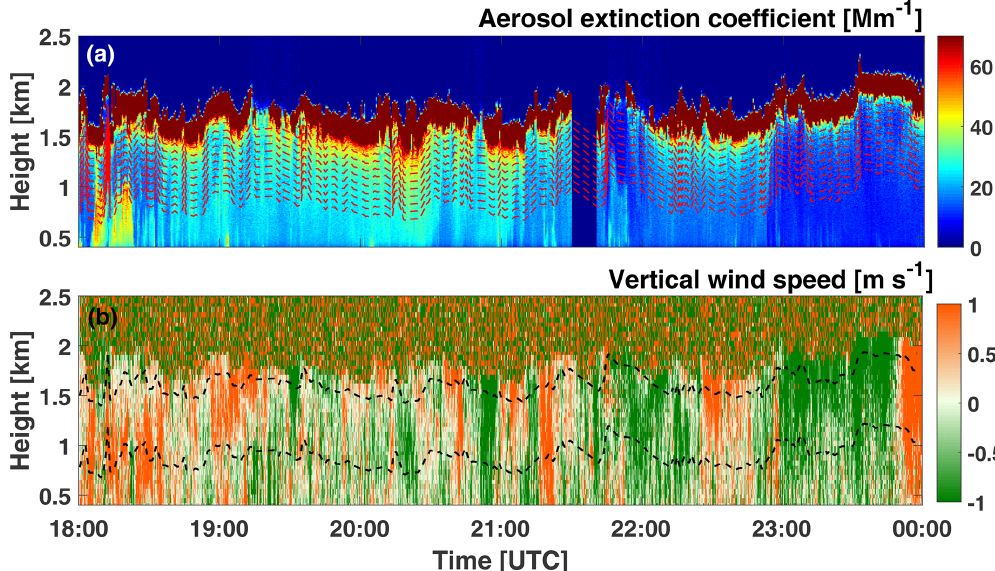
Figure 8. Lidar observation of the convective cloud-topped planetary boundary layer in the afternoon and evening of the summer day of 23 February 2019. (a) Aerosol extinction coefficient (blue to yellow colors) up to the base of the stratocumulus layer (dark red) at around 1500m height and (b) vertical wind component (orange: upward motion, green: downward motion) measured with the zenith-pointing Doppler lidar of the LACROS facility. The cloud base strongly varies with the permanently changing updraft and downdraft conditions. Dashed red curves in (a) show height levels of constant distance of 75 to 750m from the cloud base. The dashed black lines in (b) show the cloud base height z bot and the height level 750m below the cloud base. For these height levels, aerosol proxies for the ACI studies are computed as discussed below.